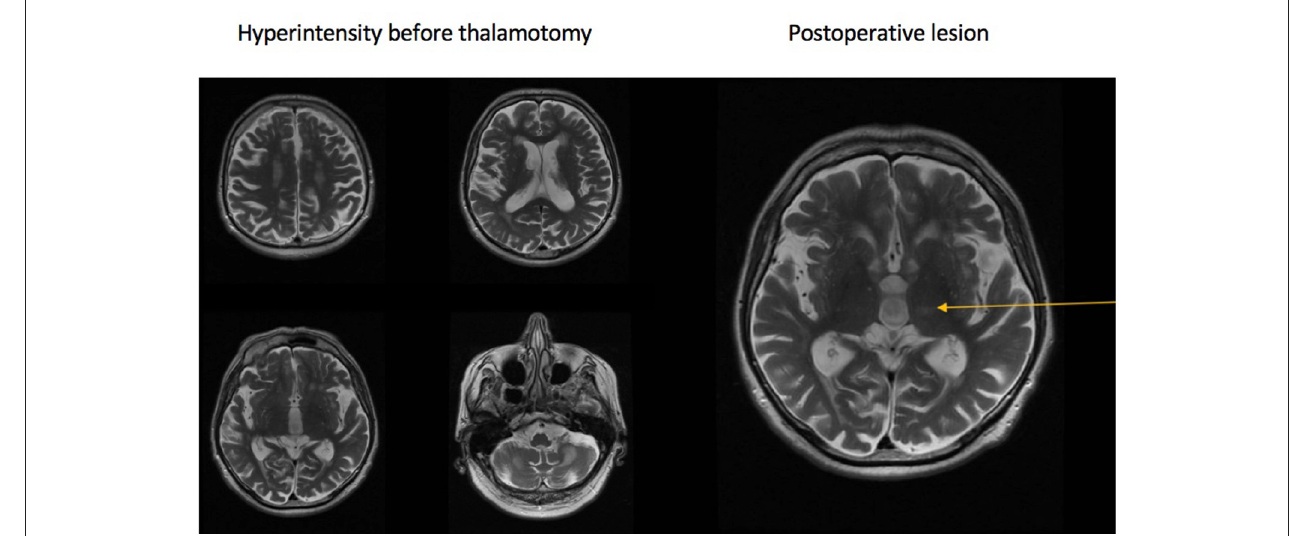
FIGURE 1 | Hyperintensities in the brain and cerebellum (left) , postprocedural lesion (right) .